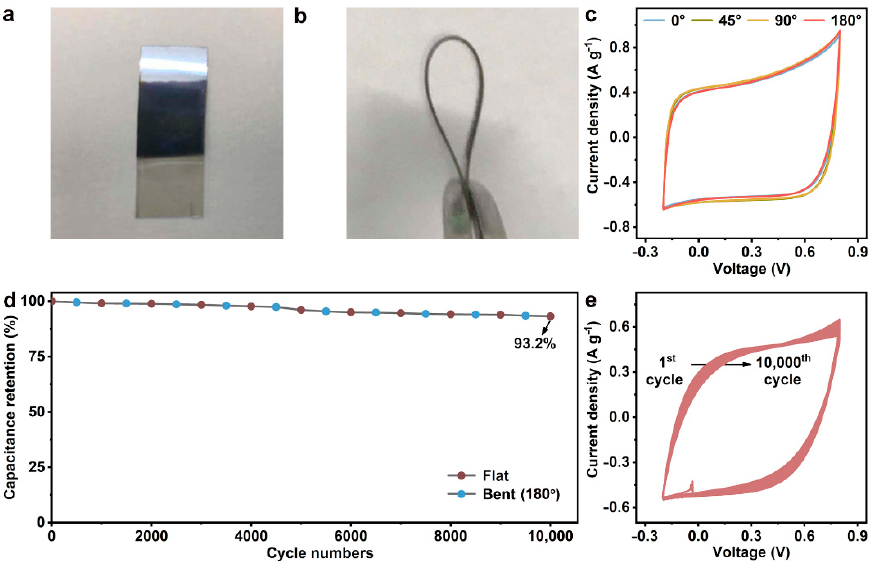
Figure 5. Flexible capacity of BP/C SC. ( a , b ) White light photographs of BP/C SC in ( a ) flat and ( b ) bent states. ( c ) Cyclic voltammetry curves at different bending degrees with a scan rate of 150 mV s − 1 . ( d ) Capacitance retention in 10,000 flat-bend tests under 100 mV s − 1 . ( e ) Cyclic voltammetry curves during 10,000 flat-bends at 100 mV s − 1 . Table 1. Performance comparisons of the BP/C SC and the reported BP-based and other supercapacitors. Electrode